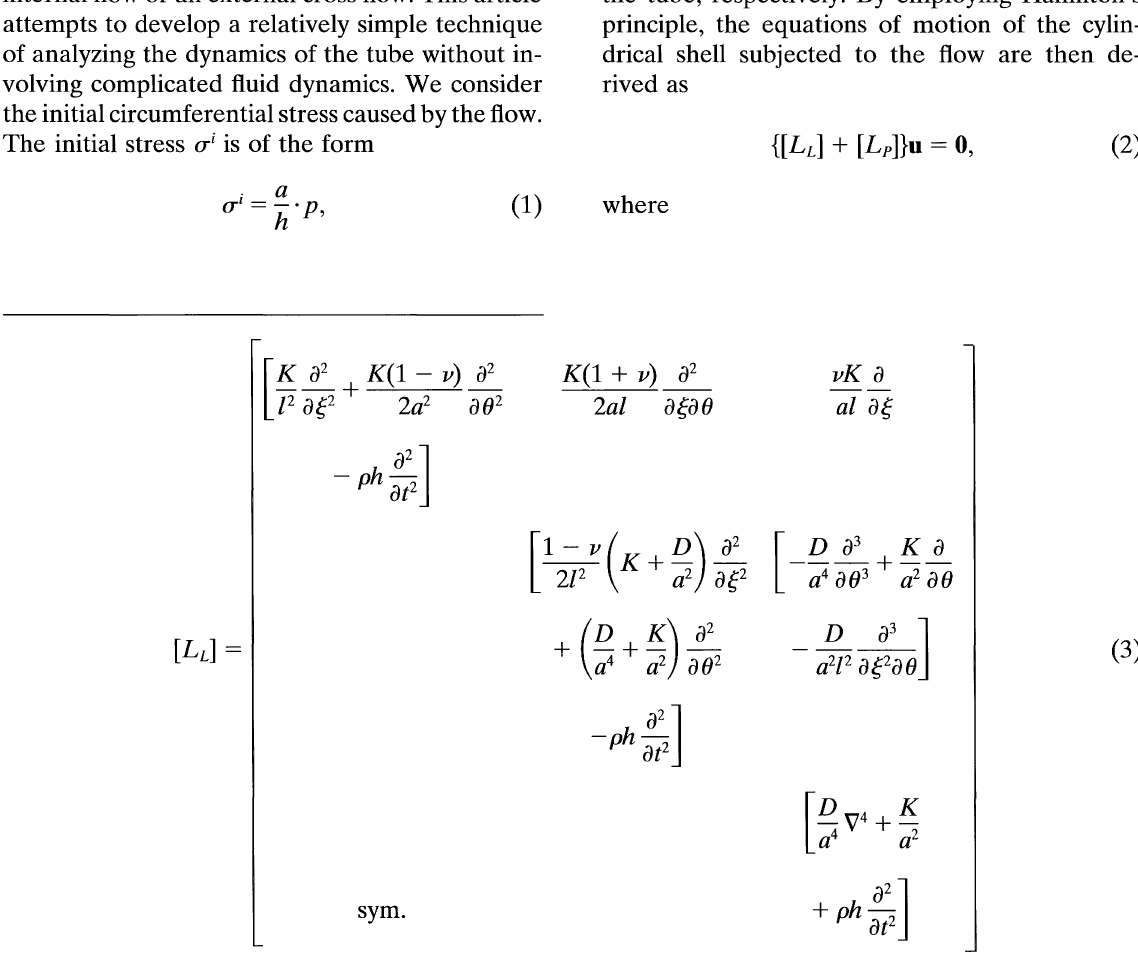
FIGURE 1 The cylindrical shell model for a tube subjected to internal and external cross